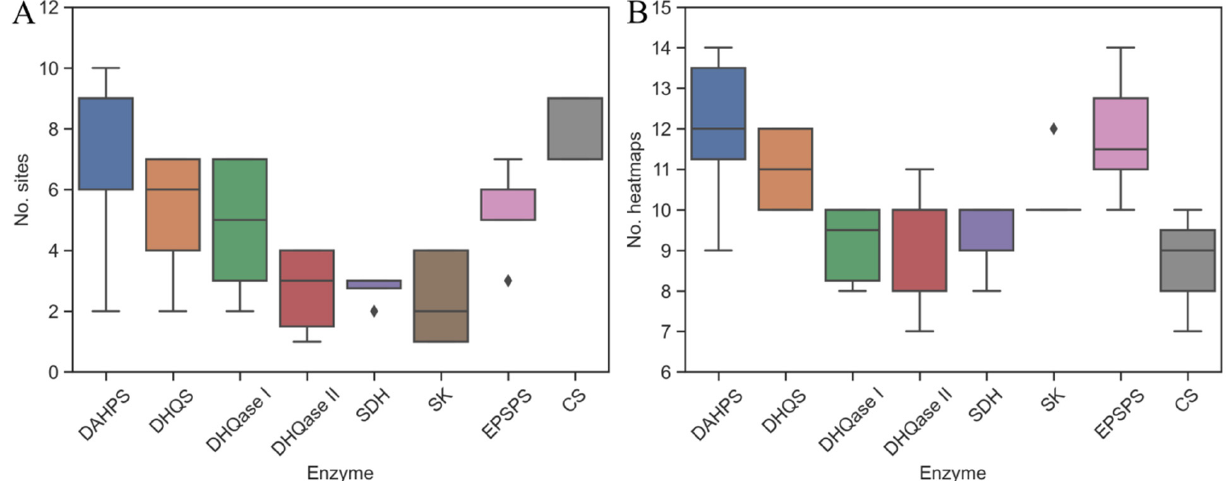
Figure 2. Identification of binding pockets: ( A ) SiteMap and ( B ) FTMap each identified several binding sites and clusters per enzyme.